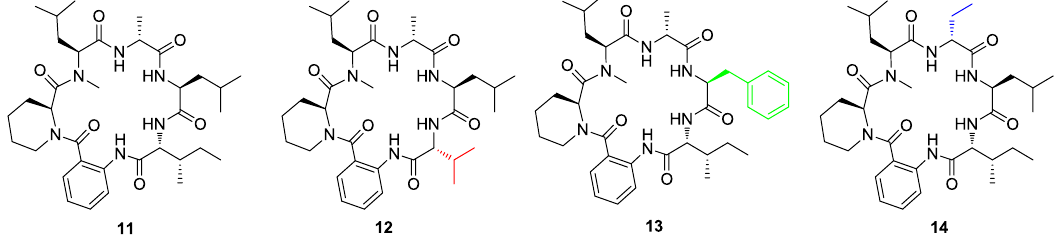
Figure 3. Structures of naturally occurring cyclohexapeptides 11 – 14 .